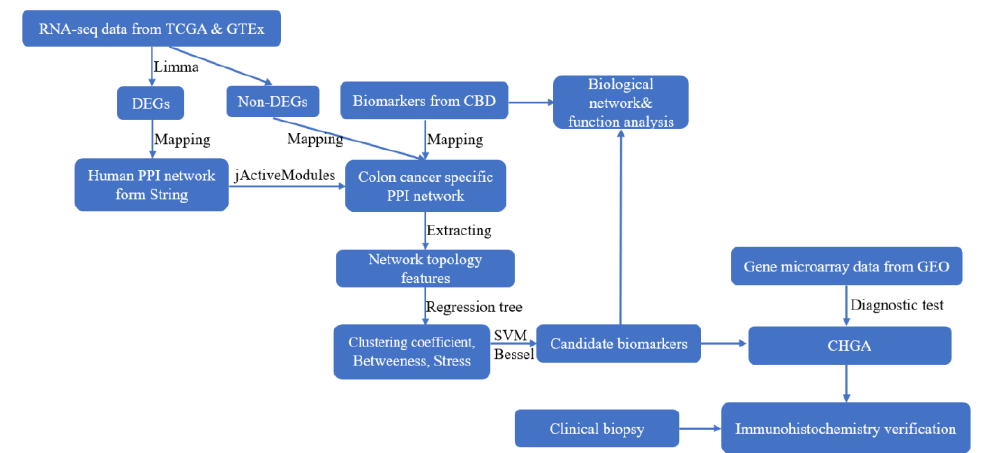
Figure 1. Schematic flow chart of the present study for early diagnosis of colon adenocarcinoma. The starting materials were derived from the RNA seq data in the TCGA and GTEx databases. Differential expressed analysis (DEA) between the colon cancer patients and normal controls was conducted. The differential expressed (DE) genes were then mapped to the Human PPI network (from String) to construct a colon cancer-specific PPI network, and machine learning was used to predict new potential biomarkers based on the network features of the confirmed biomarkers from our CBD database. The diagnostic test (ROC test) of the predicted biomarkers were further verified in GEO microarray data. The candidate biomarker (CHGA) was finally confirmed by immunohistochemistry tissue microarrays.